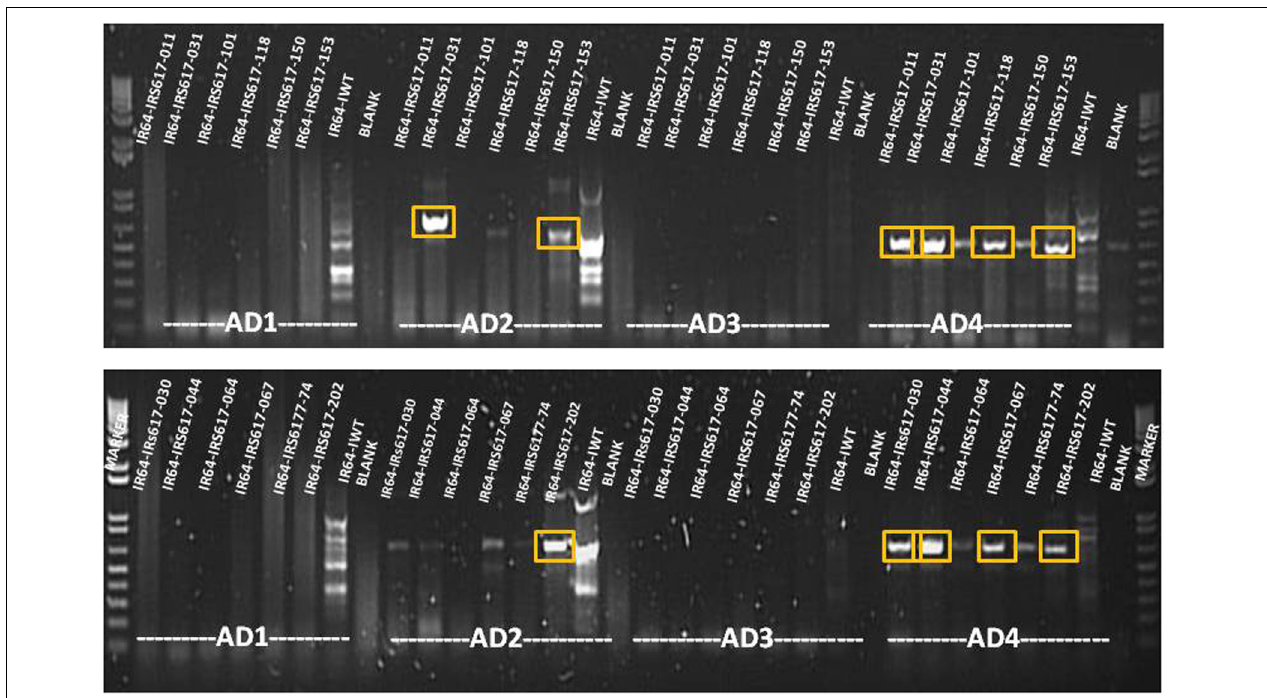
FIGURE 4 | Agarose gel analysis of TAIL PCR products amplified from GUS-positive insertion lines. Bands shown in boxes were cut and sequenced. AD1, AD2, AD3, and AD4 = non-specific primers.